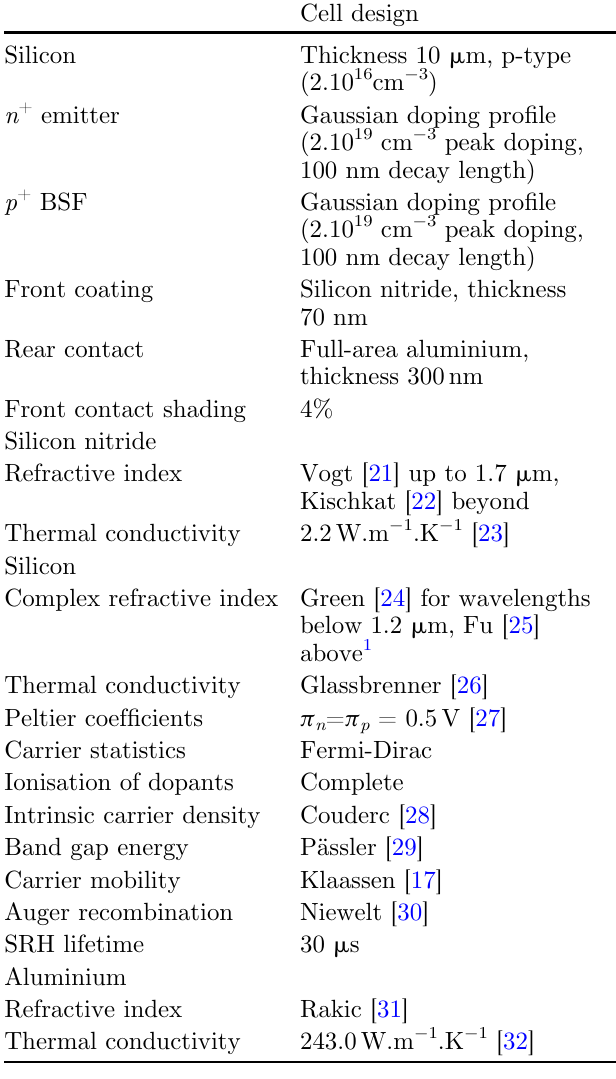
Table 1. Input parameters and models for the simulated reference solar